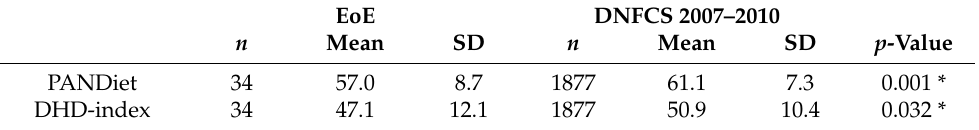
Table 3. Comparison of Diet Quality Index scores between EoE patients and the general Dutch